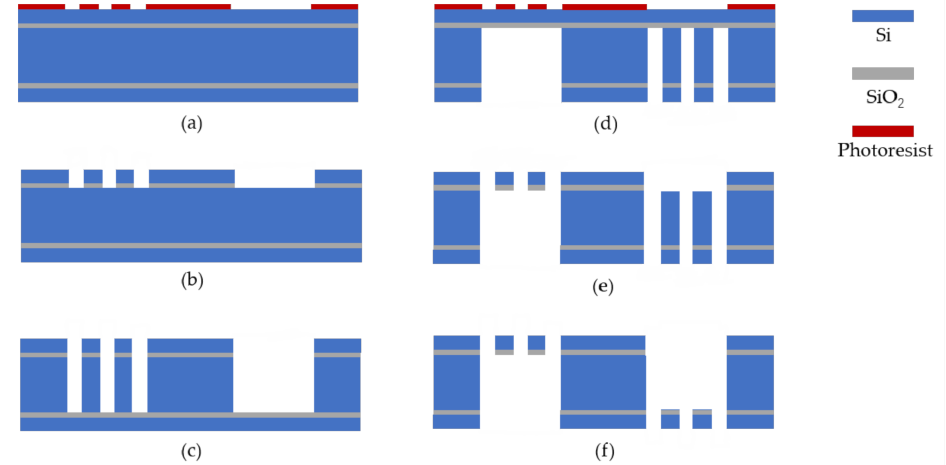
Figure 7. ( a )–( f ) Cross-sectional view of the fabrication process flow of the MEMS sensing